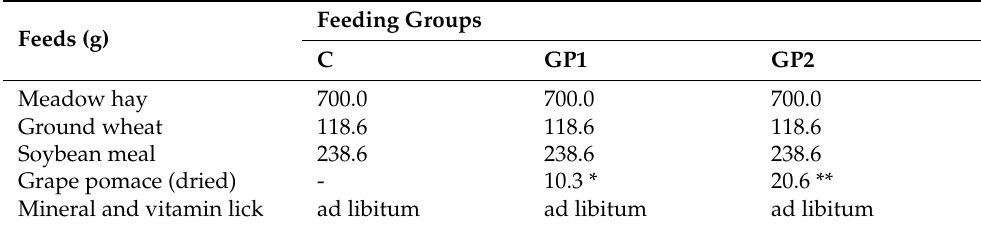
Table 2. Feed rations used in the digestibility experiment. Feeding Groups Feeds (g) C GP1 GP2 Meadow hay 700.0 700.0 700.0 Ground wheat 118.6 Soybean meal 238.6 238.6 238.6 Grape pomace (dried) - 10.3 * 20.6 ** Mineral and vitamin lick ad libitum ad libitum